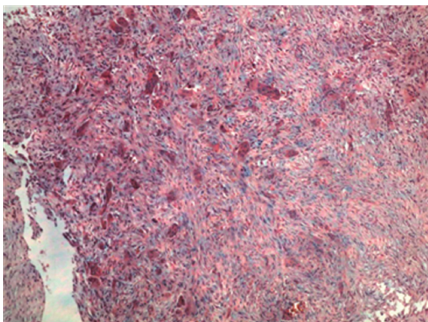
Figure 1: Lateral X-ray of the right radioulna showing osteitis fibrosa cystica lesion of ulna diaphysis with a pathologic fracture (before curettage).